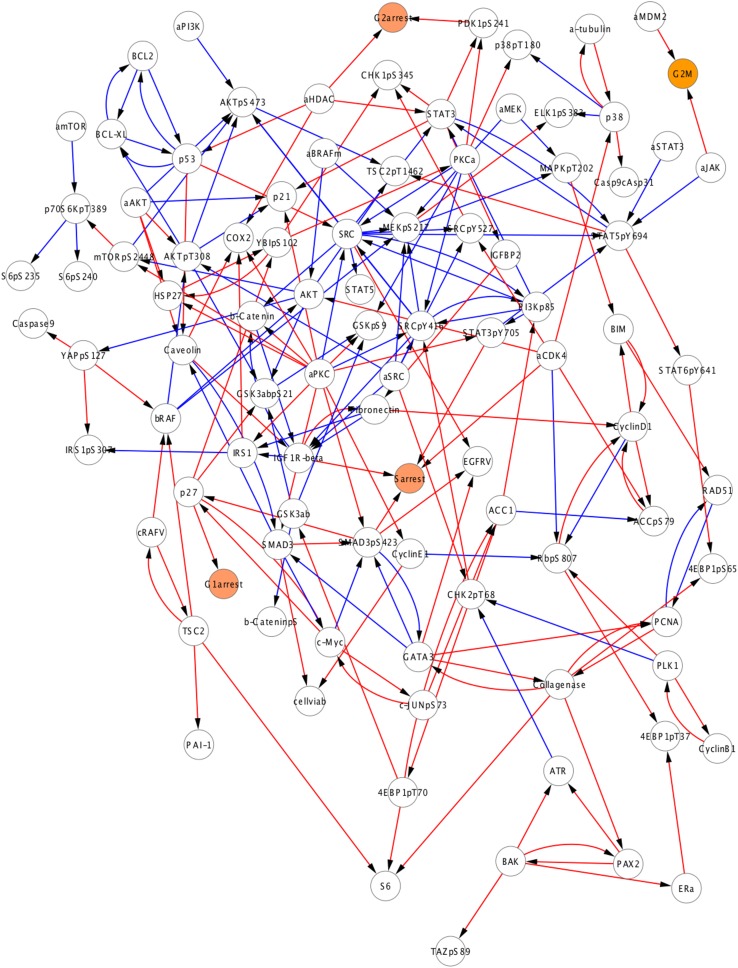
A subset of the prior information is represented in the average network model.The average model, which was generated from the solutions inferred with the BP-guided decimation algorithm, contains 202 interactions in total and 89 of these interactions (blue edges) are also sampled in the qualitative prior model, which contains 154 interactions. 65 prior edges are not represented in the average model as the prior bias in network inference did not conform to the experimental data and not accepted frequently in the model ensemble. Note that a majority of the interactions in the prior set is sampled by only a fraction of the models; however, those interactions are not sufficiently strong and/or frequent that they are not captured in the average model (Figure 4—figure supplement 2).